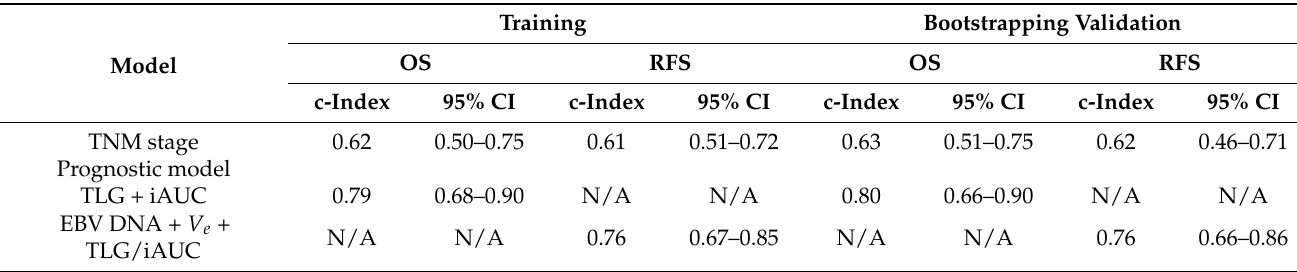
Table 5. Harrell’s concordance indices of the prognostic models and TNM stage in the training cohort and bootstrapping